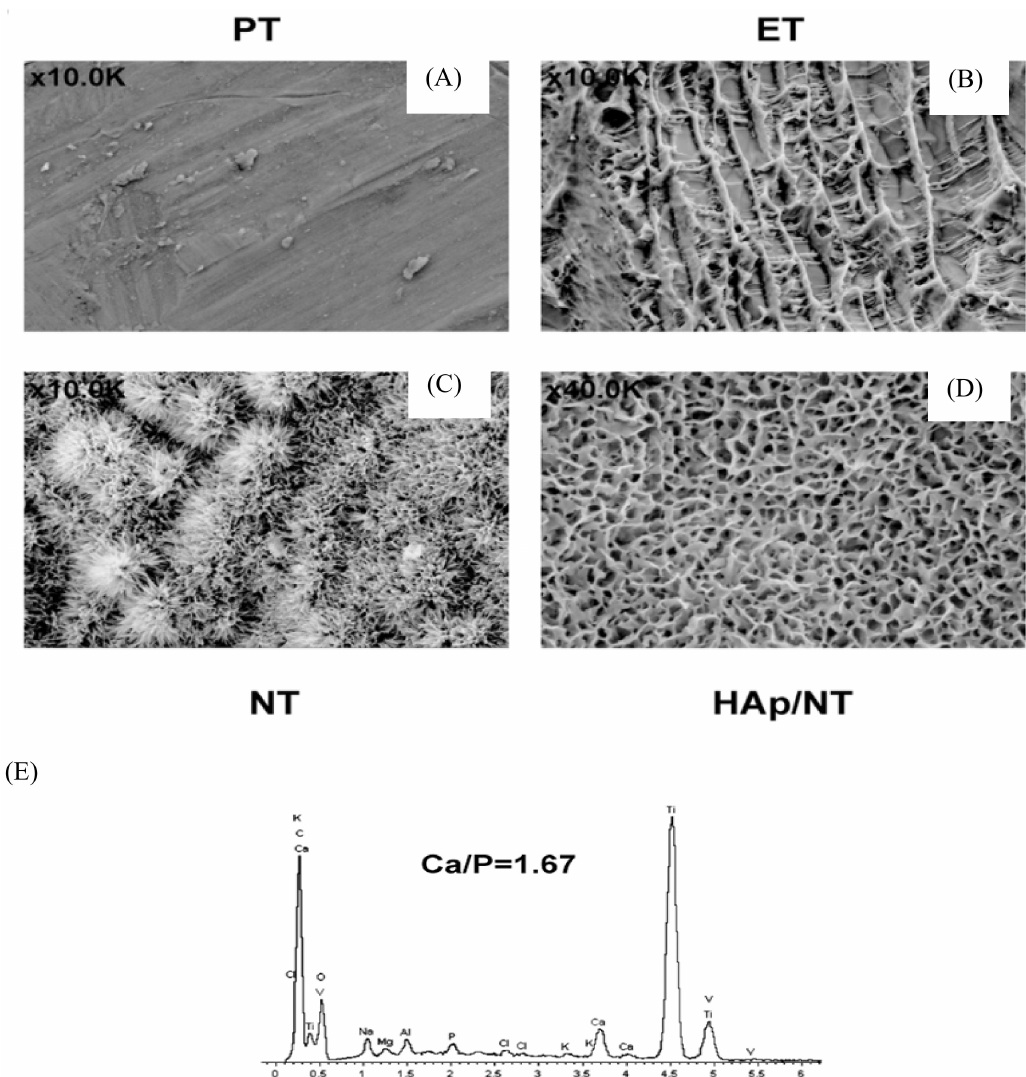
Figure 4. Scanning electron microscopic image of ( A ) polished titanium, PT, ( B ) Acid-Etched, ET, ( C ) Etched titanium exposed to sodium hydroxide, NT and ( D ) hydroxyapatite deposited on NT, HAp / NT. ( E ) EDS analysis of the surface of HAp / NT, highlighting the ratio of calcium (Ca) to phosphorus (P). (Reproduced with permission from Liu et al., Rapamycin / sodium hyaluronate binding on nano-hydroxyapatite coated titanium surface improves MC3T3-E1 osteogenesis; published by PLOS ONE, 2017, CC BY 4.0